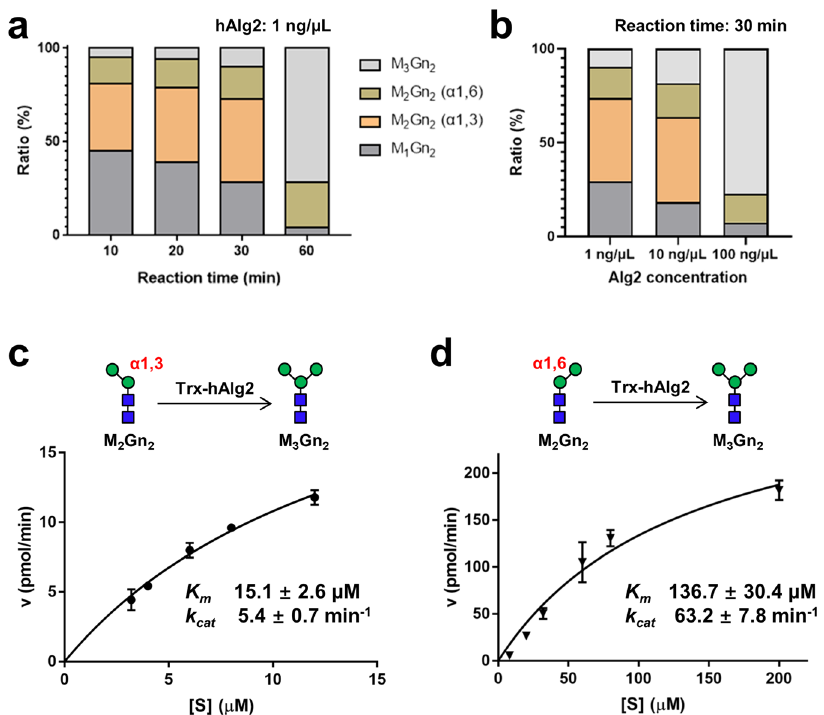
Fig. 6 Kinetic analysis of M 3 Gn 2 formation. a The percentage of each component in the reaction as a function of time. The reaction was performed using puri fi ed Trx-hAlg2 (1 ng/ μ L) with the standard reaction mixture. b The percentage of each component in the reaction system as a function of Alg2 concentration. The reactions were performed using puri fi ed Trx-hAlg2 (1, 10 and 100 ng/ μ L) with the standard reaction mixture at 37 °C for 30 min. c The K m (15.1 ± 2.6 μ M) and k cat (5.4 ± 0.7 min − 1 ) values for the substrate M 2 Gn 2 ( α -1,3) (black dots) were calculated by nonlinear regression (GraphPad Prism 7) with a constant concentration of 2 mM GDP-Man. Each data point represents the mean value calculated from n = 3 independent experiments. Error bars represent standard deviations. d The K m (136.7 ± 30.4 μ M) and k cat (63.2 ± 7.8 min − 1 ) values for the substrate M 2 Gn 2 ( α -1,6) (black triangles) were calculated by nonlinear regression (GraphPad Prism 7) with a constant concentration of 2 mM GDP-Man. Each data point represents the mean value calculated from n = 3 independent experiments. Error bars represent standard deviations. Note the difference in values on the X and Y axes on graphs shown in c , d